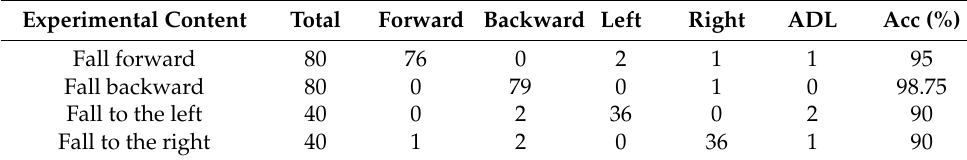
Table 7. Test results for the direction of fall.